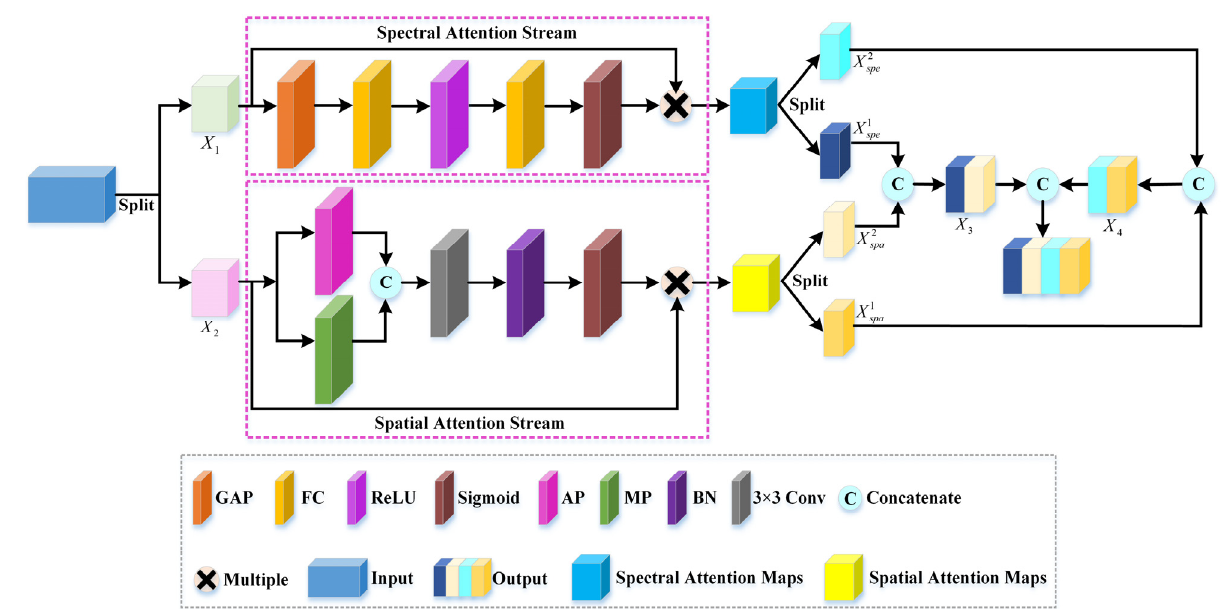
Figure 4. The structure diagram of rearranged attention module (RAM).